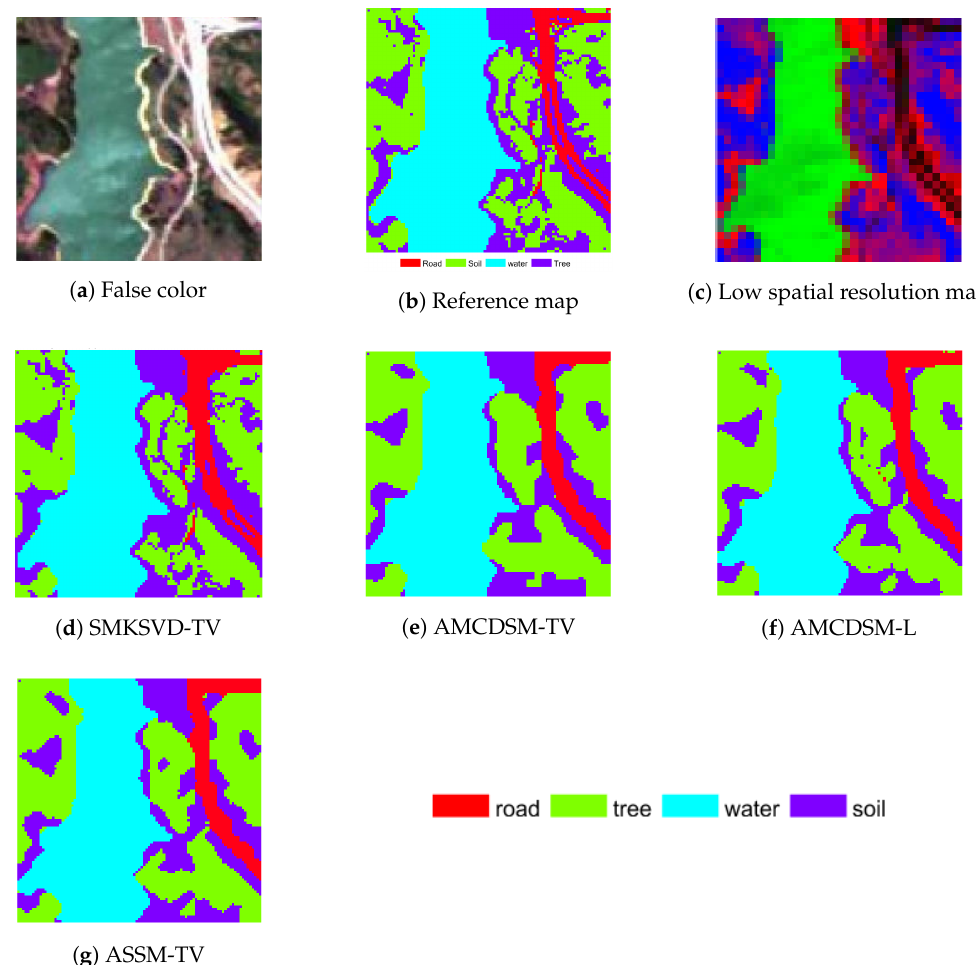
Figure 5. Jasper ridge hyperspectral data: ( a ) false color Jasper ridge hyperspectral image, ( b ) ref- erence map ( c ) down-sampled low spatial resolution image using a scale factor of 3, ( d ) the pro- posed SMKSVD-TV, ( e ) AMCDSM-TV result, ( f ) AMCDSM-L result, and ( g ) ASSM-TV